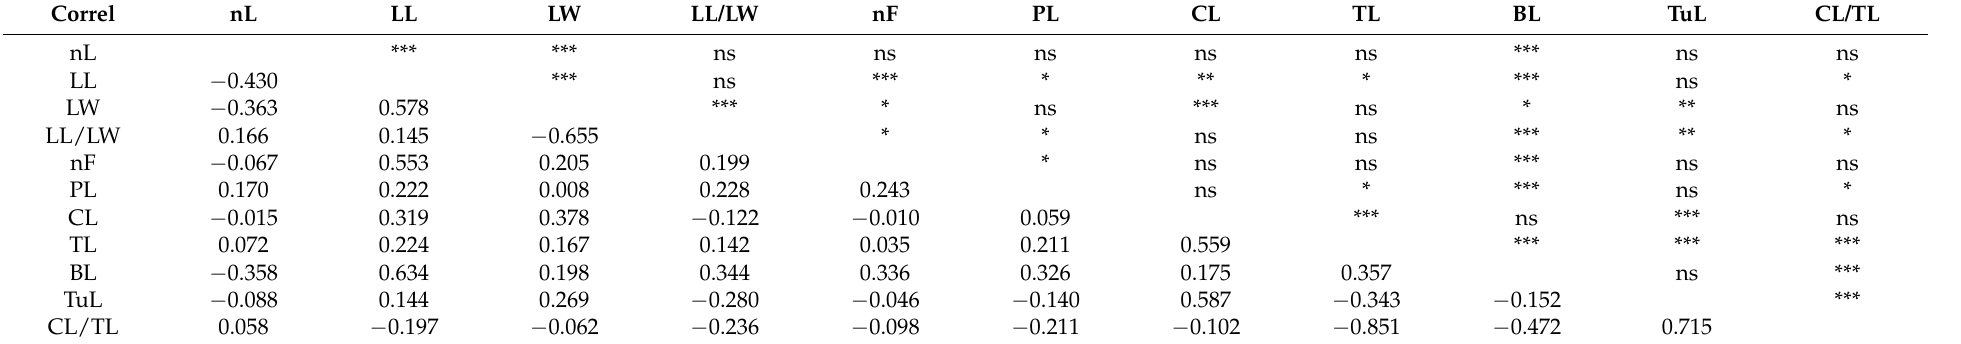
Table 6. Pearson’s correlation coefficient of 11 morphological traits from ten Micromeria croatica